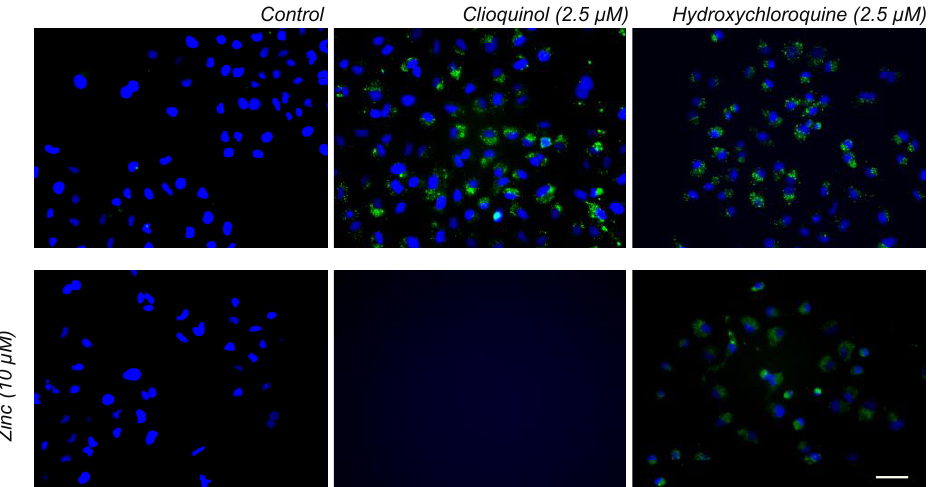
Figure 9. Fluorescence images of A549 cells stained with FluoZin-3 AM (green) and counterstained using NucBlue Live for nuclei (blue) after 24 h incubation with CQ or HCQ and with basal and additional 10 µM zinc. Magnification ×10, scale bar 50 µm.